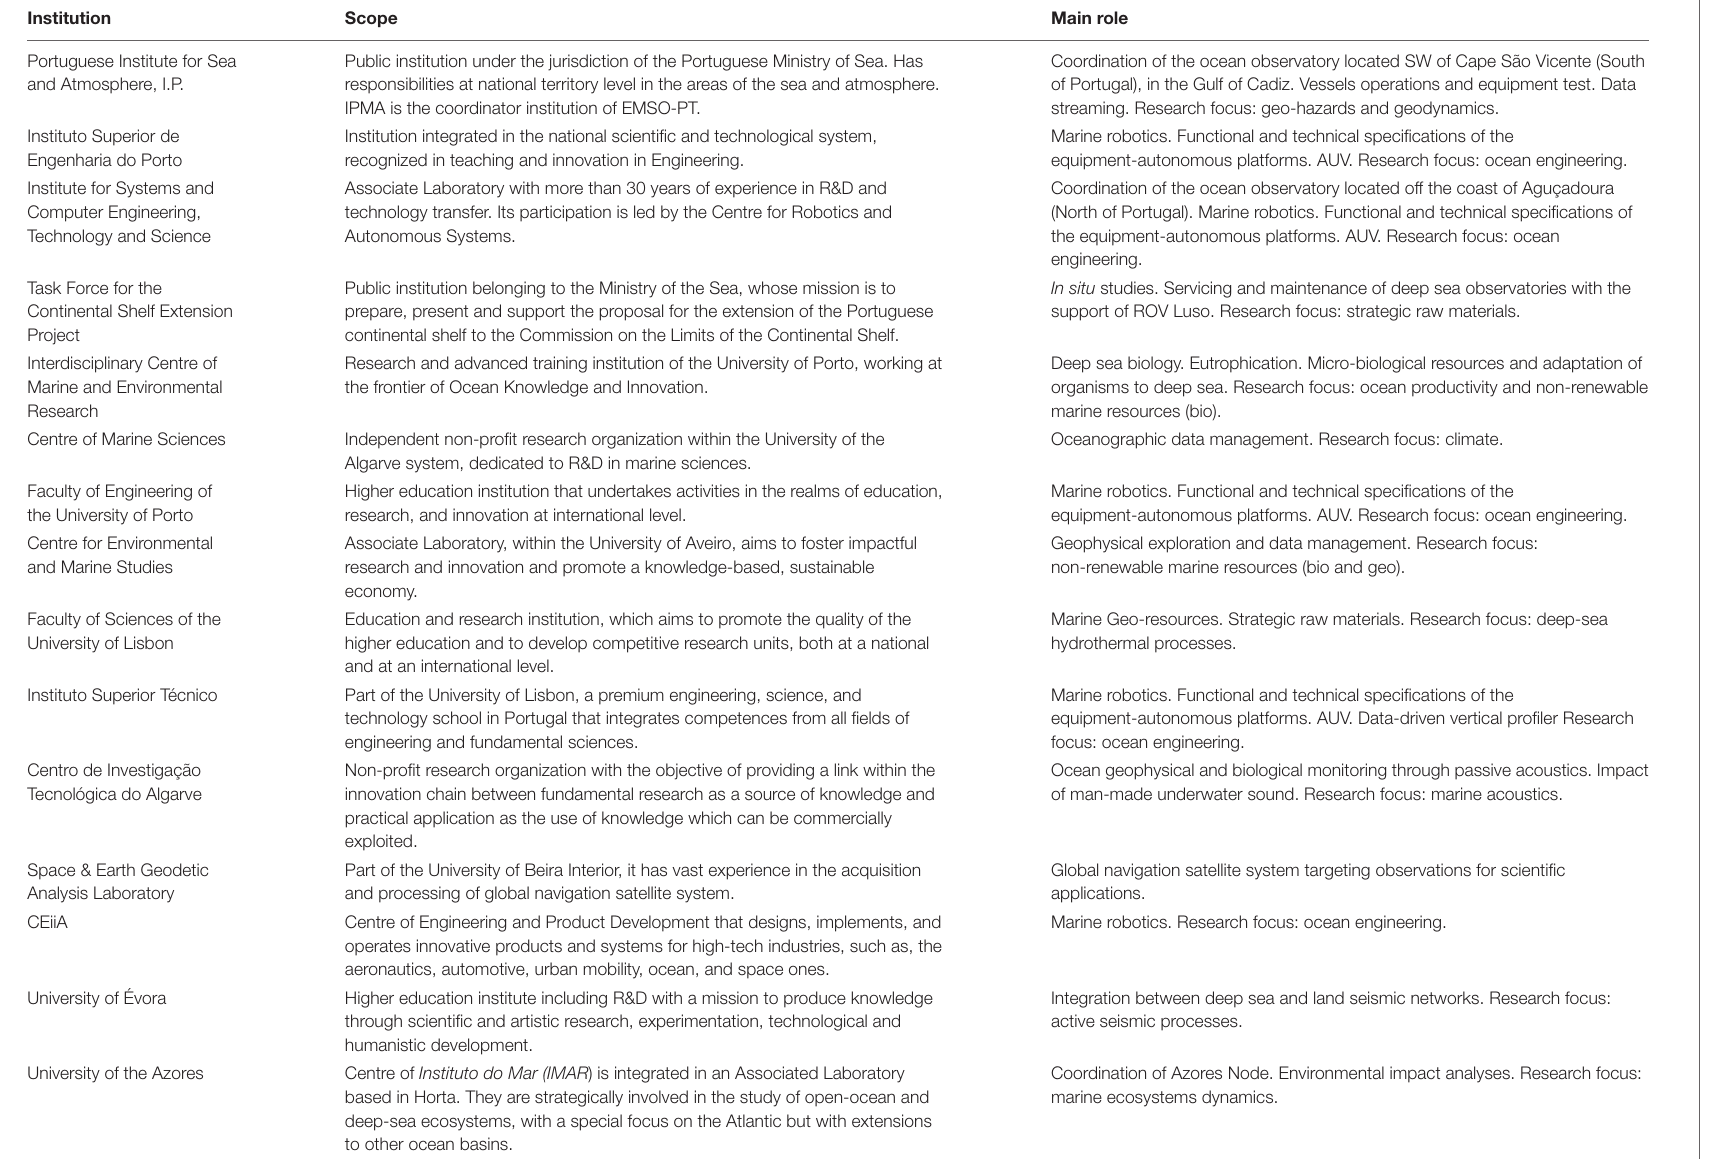
TABLE 1 | Members of